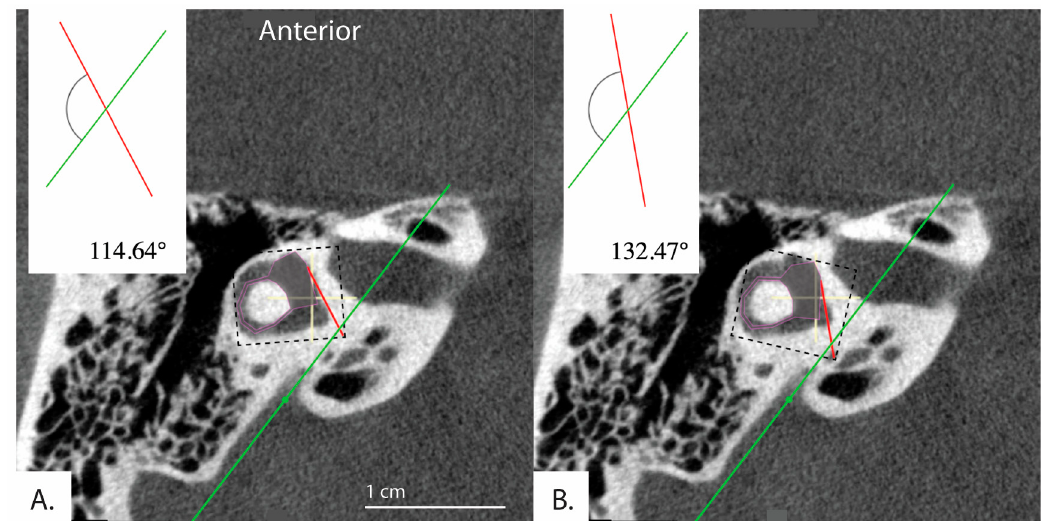
Figure 4. Example demonstrating variability in the determined angle depending on application of the tool. Bächinger et al. software used to measure angles in the same image. ( A ) 𝑎 (cid:3032)(cid:3051)(cid:3036)(cid:3047) =114.64 ° and ( B ) 𝑎 (cid:3032)(cid:3051)(cid:3036)(cid:3047) = 132.47°. Depending on the settings of the software, different angles for the same image can result.